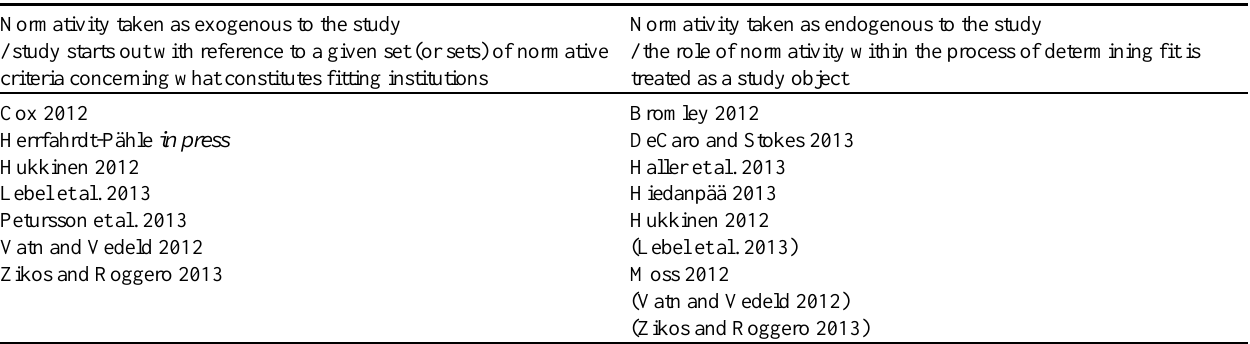
Table 1 . Perspectives on normativity. Normativity taken as exogenous to the study / study starts out with reference to a given set (or sets) of normative criteria concerning what constitutes fitting institutions